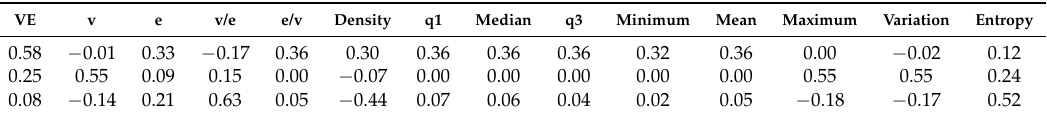
Table 3. The individual components in the Principal Component Analysis. Each row refers to one of the three components. The leftmost column shows how much of the total variance of the data is explained by that component; all other columns show how the respective feature is factored into the component.